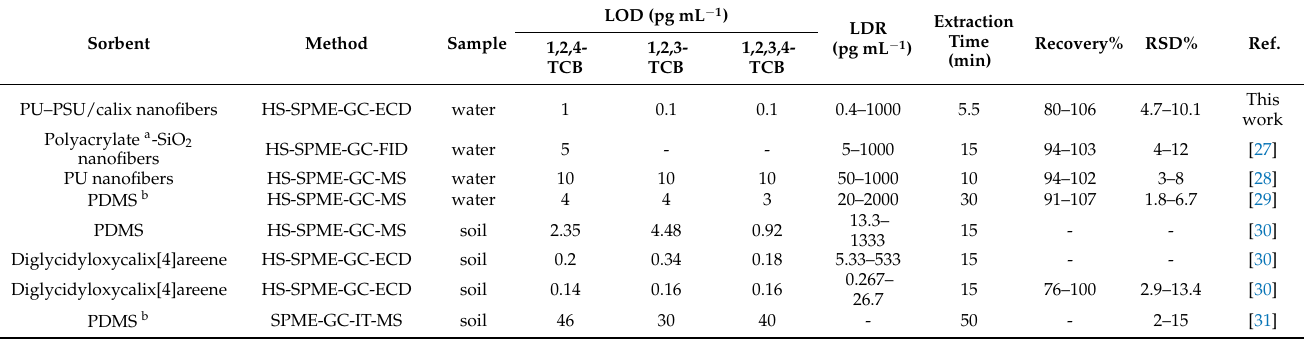
Table 3. Comparison of HS-SPME/GC-ECD analysis with other methods for determination of